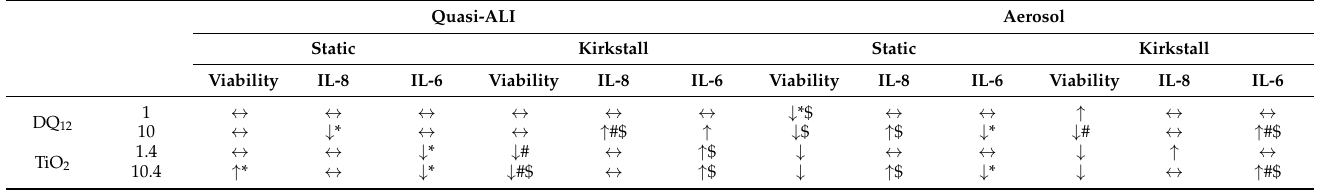
Table 2. Summary of data. Trend is indicated by arrow and significance is indicated by appropri- ate